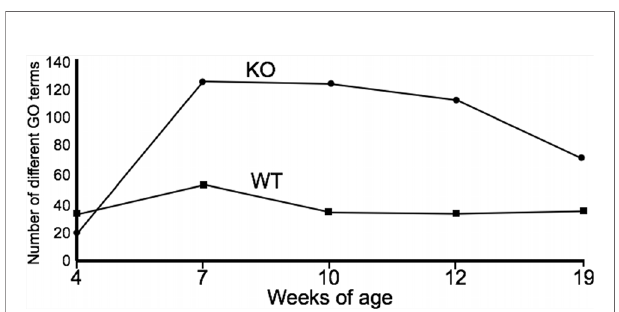
FIGURE 2 | Summary of PICRUSt analysis. The number of GO terms are shown at each point of the study for WT and IL-10 -/- mice, as indicated. The number of mice used for each strain at each time point varied as follows: at 4 weeks of age, n = 5; at 7 weeks of age, n = 10; at 10 weeks of age, n = 9; at 12 weeks of age, n = 13; at 19 weeks of age, n